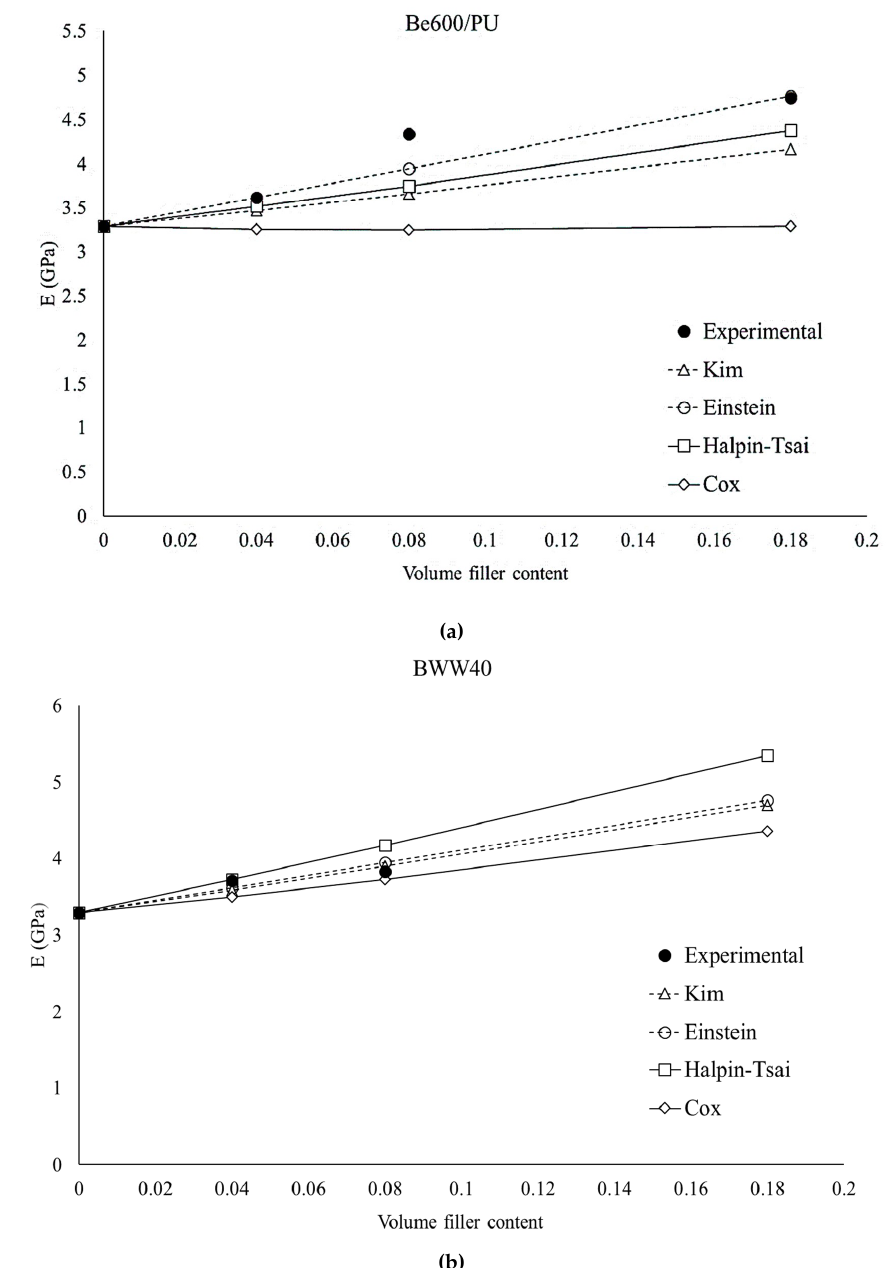
Figure 5. Comparison between experimental elastic modulus of the blends and mathematical models for ( a ) Be600/PU–PLA composites and ( b ) BWW40–PLA composites.